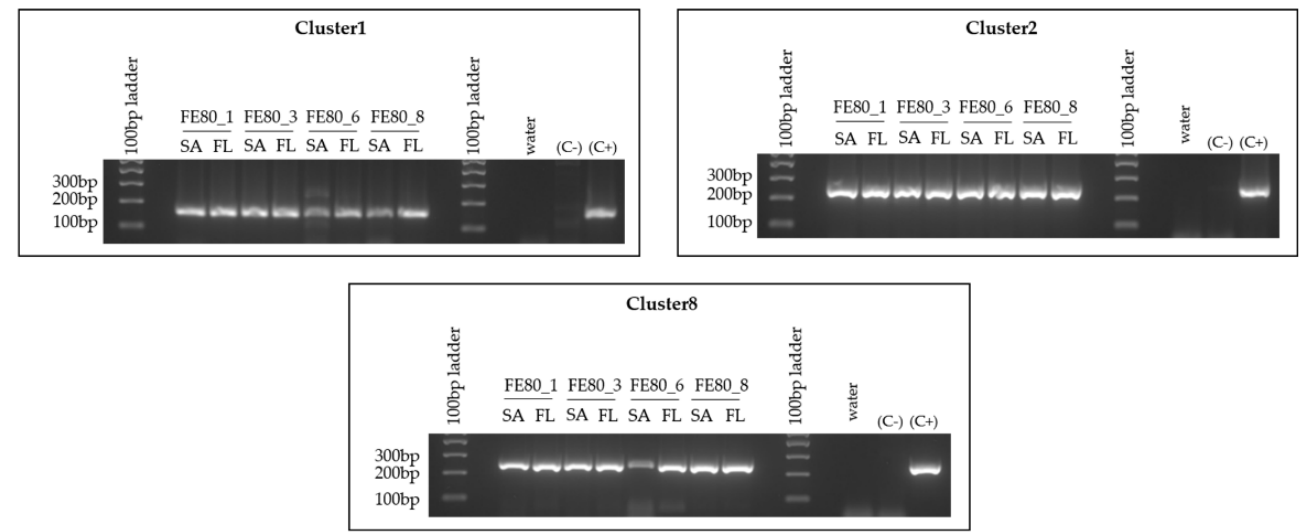
Figure 6. Reintroduction of the bacterial species to T. rotula FE80. Cl-1, Cl-2 and Cl-8 PCR amplifications were performed on gDNA extracted separately from the FL and SA fractions associated with the T. rotula FE80 cultures after the reintroduction of the S. marinoi FE7 associated -FL bacterial fraction. Abbreviations: C+: positive control = S. marinoi FE7 xenic total culture gDNA; C-: negative control = T. rotula FE80 axenic total culture-gDNA (before reintroduction of bacteria to the culture); FE80_1 = 1 month after the reintroduction; FE80_3 = 3 months after the reintroduction; 6 = 6 months after the reintroduction; FE80_8 = 8 months after the reintroduction of the bacteria. FE80 = T. rotula clone FE80.